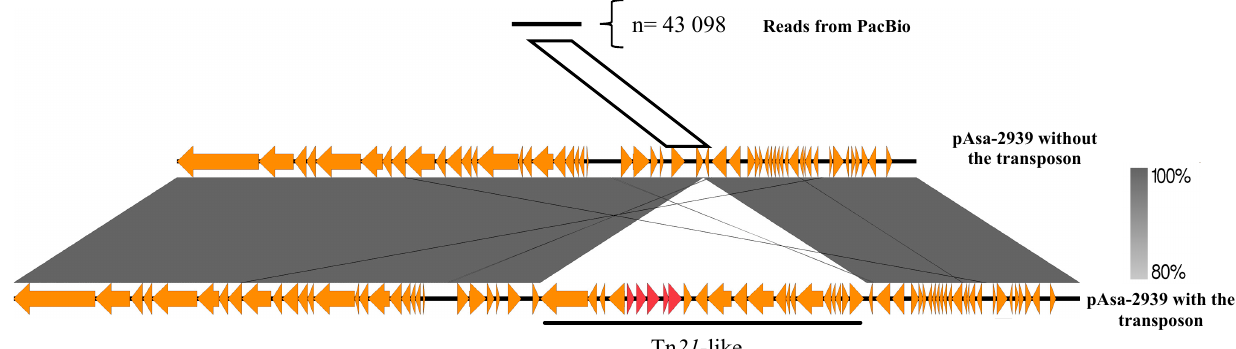
Figure 4. Transposon instability in SHY15-2939 confirmed by bioinformatics analysis. Comparison between a read from PacBio and the sequence of pAsa-2939 without the transposon (theoretical) and the pAsa-2939 plasmid including the transposon. The gray area represents similarities between the two plasmid versions. The red arrows represent the ARGs and the orange arrows represent other genes. The white parallelogram represents the region used to detect PacBio reads corresponding to the junction consequent to transposon excision.